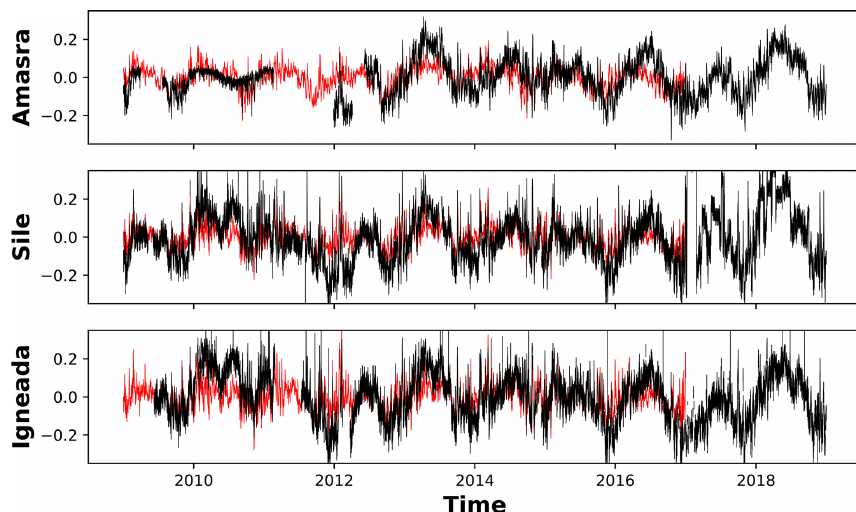
Figure 10. Time series of sea surface height anomaly (m) for the three tide gauge stations shown in Fig. 1: (a) Amasra, (b) ¸Sile and (c) ˙I˘gneada. Model results are indicated by the black line and the tide gauge record is indicated by the red line.